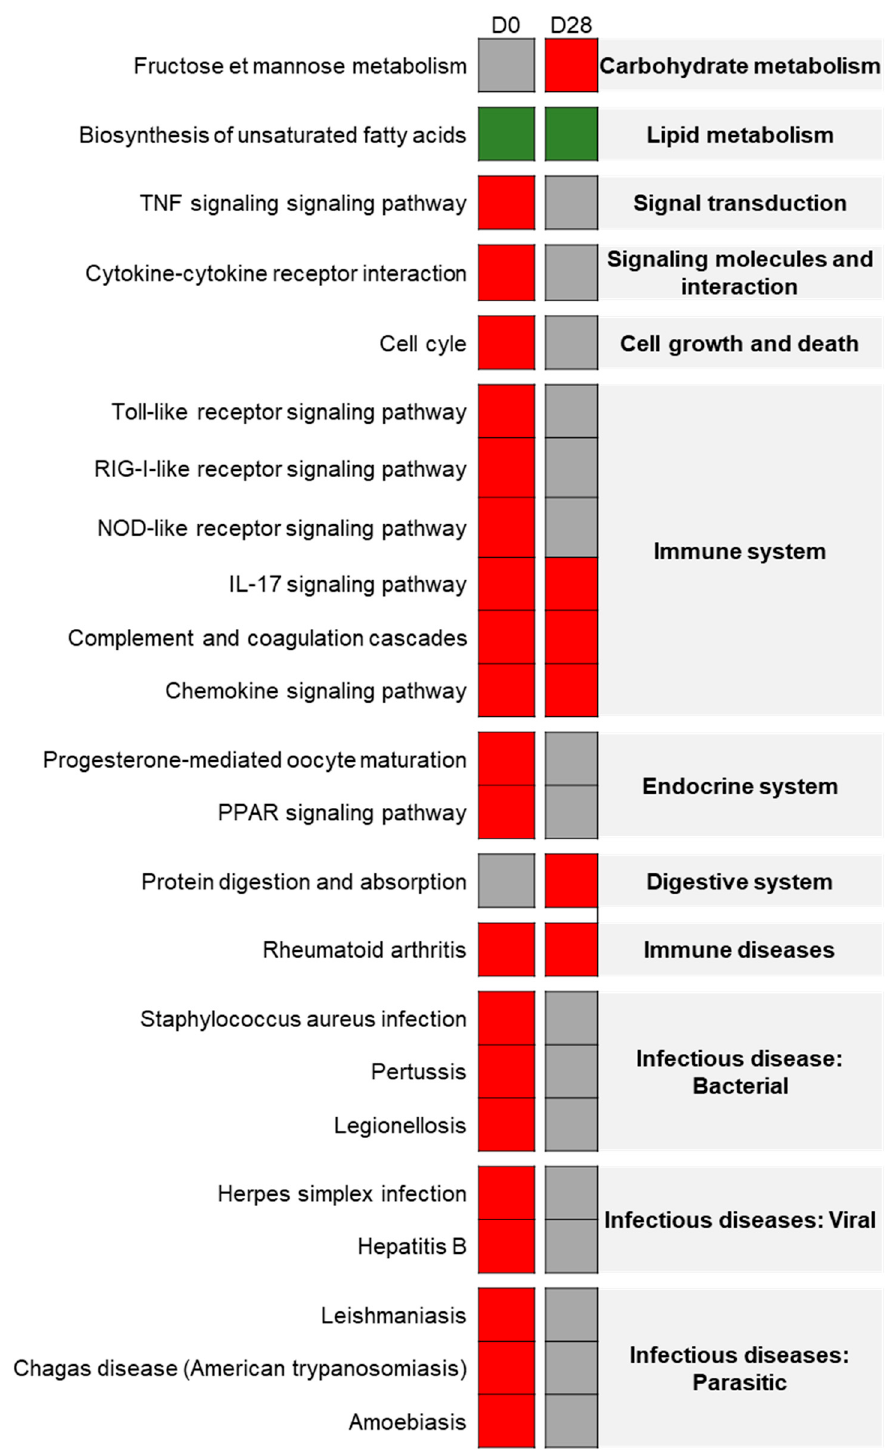
Figure 5. Exposure effect on elderly rats: Heatmap from the FunMappOne tool. The first column represents the data for D0 and the second for D28. The color of the boxes represents the expression of a majority of the genes involved in this pathway: green for under-expression in exposed group compared to controls, red for over-expression, and grey for no difference.